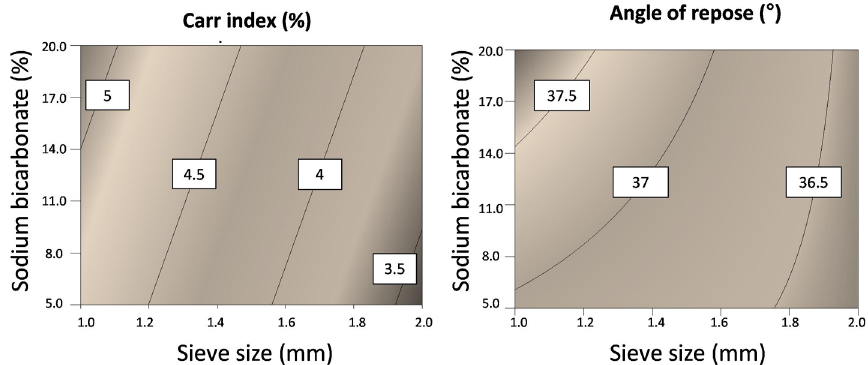
FIGURE 2 - Contour diagrams of Maytenus ilicifolia effervescent granules developed according to factorial design for the Carr index and the angle of repose. Each contour represents a constant response